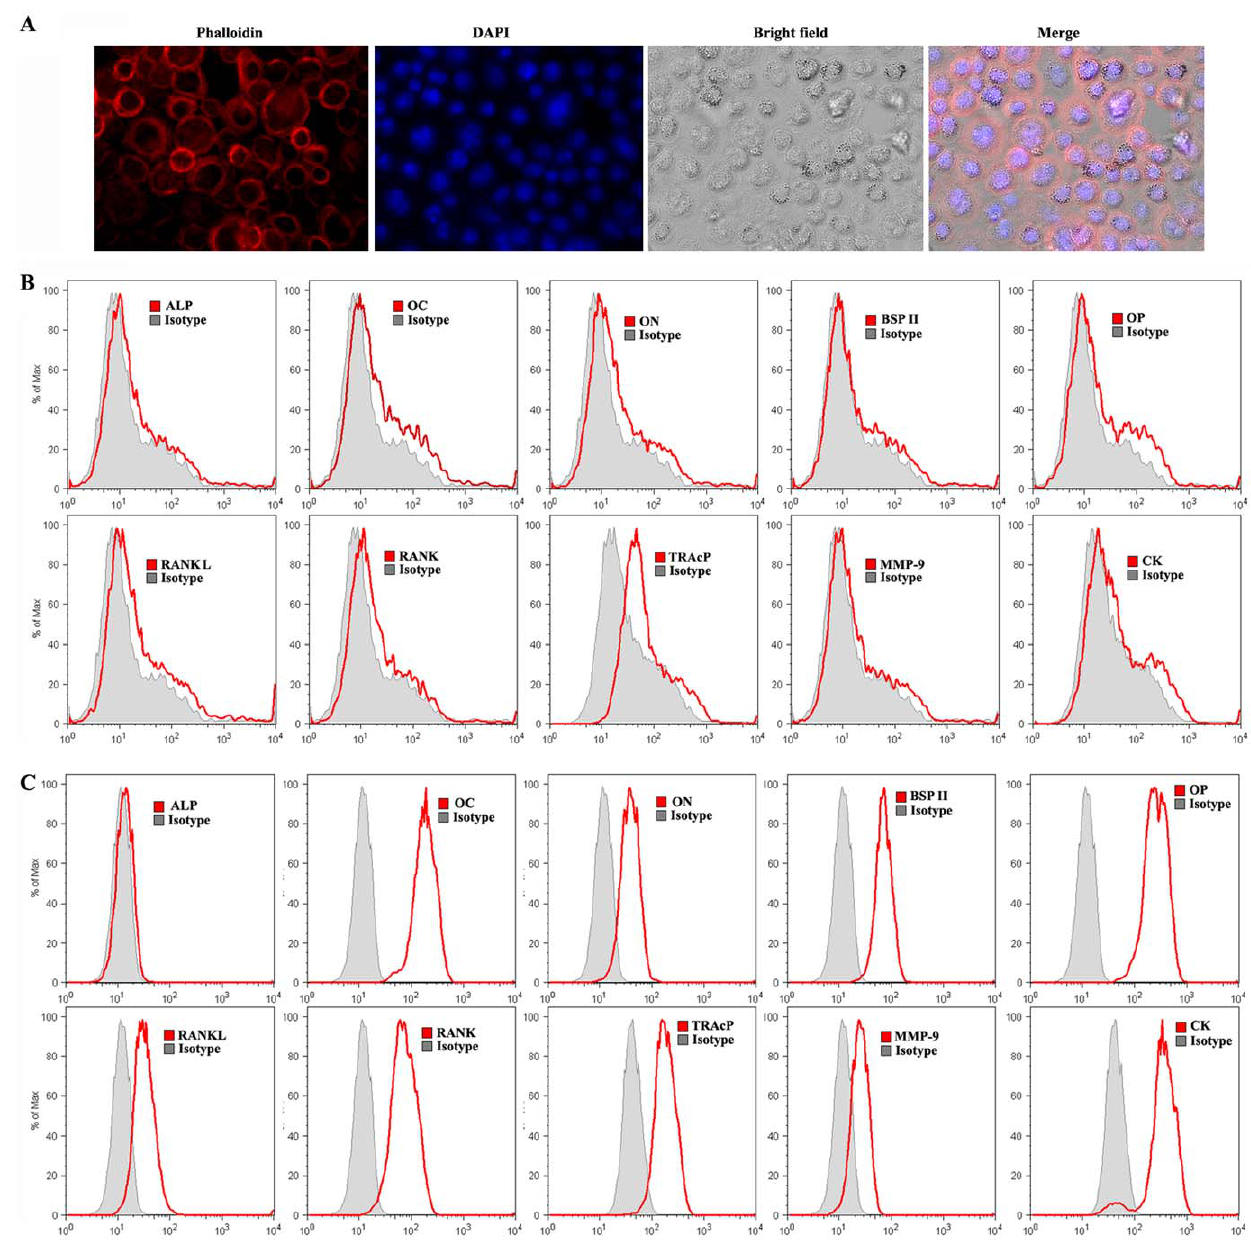
Figure 6. Characteristics of monoosteophils. Monocytes were incubated in the presence of 5 m M LL-37 for 6 days. A . cells were fixed, permeabilized, stained with phalloidin-Alexa 594 and DAPI, and observed by using fluorenscence microscope. B . cells were harvested, stained with antibodies, and analyzed by using flow cytometry to show surface staining of proteins. C . Cells were harvested, fixed and permeabilized, stained with antibodies, and analyzed by using flow cytometry to show intracellular staining of proteins. Data shown were from one of four independent